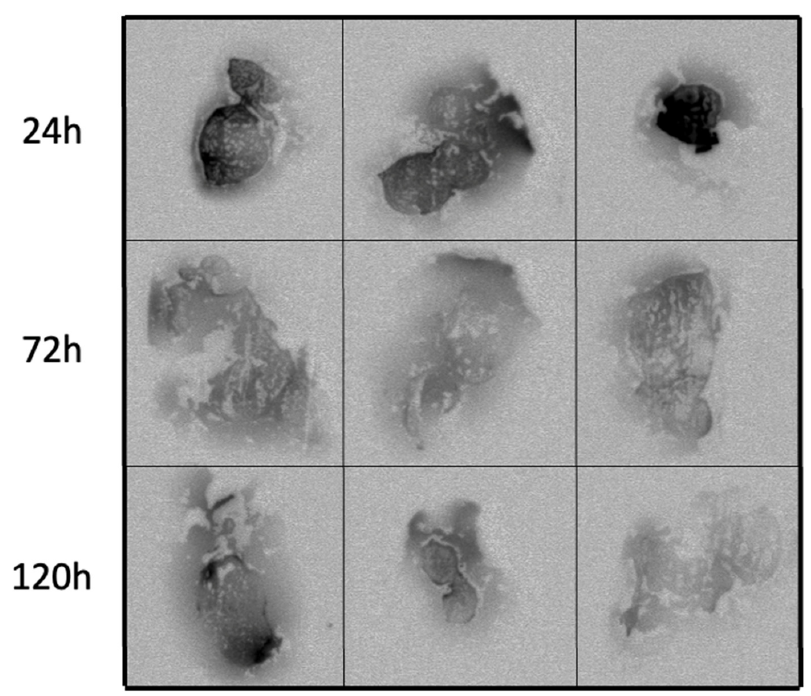
Figure 4. Autoradiography of tumors treated with a single intratumoral injection of RT shows distribution in the TME. C57/Bl6 mice bearing subcutaneous E0771 tumors were treated with a single intratumoral dose of RT (0.15–0.30 MBq). Mice were sacrificed at 24, 72, and 120 h after treatment, and tumors were harvested and flash frozen for autoradiography. Each image represents a slice of an individual tumor. The darker the area, the more radioactive decay that was detected in that area.